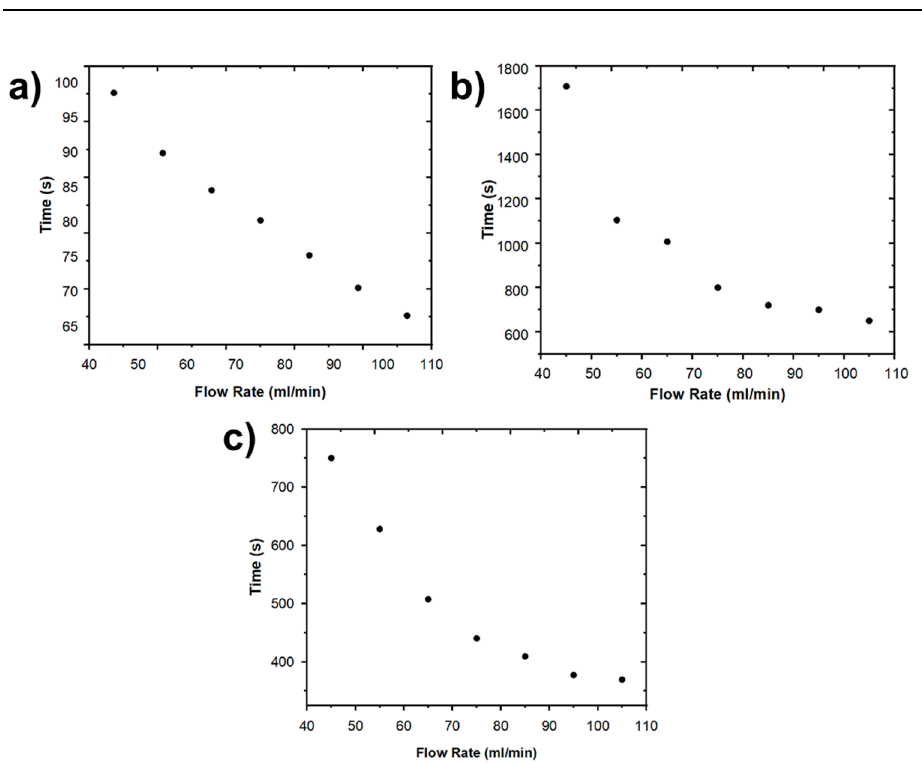
Figure 6. Time as a function of flow rate (NaCl 0.4 M, 1.2 V) to reach: ( a ) The ionic equilibrium (lower concentration), ( b ) the initial concentration (charge stage), and ( c ) the initial concentration after discharge stage.